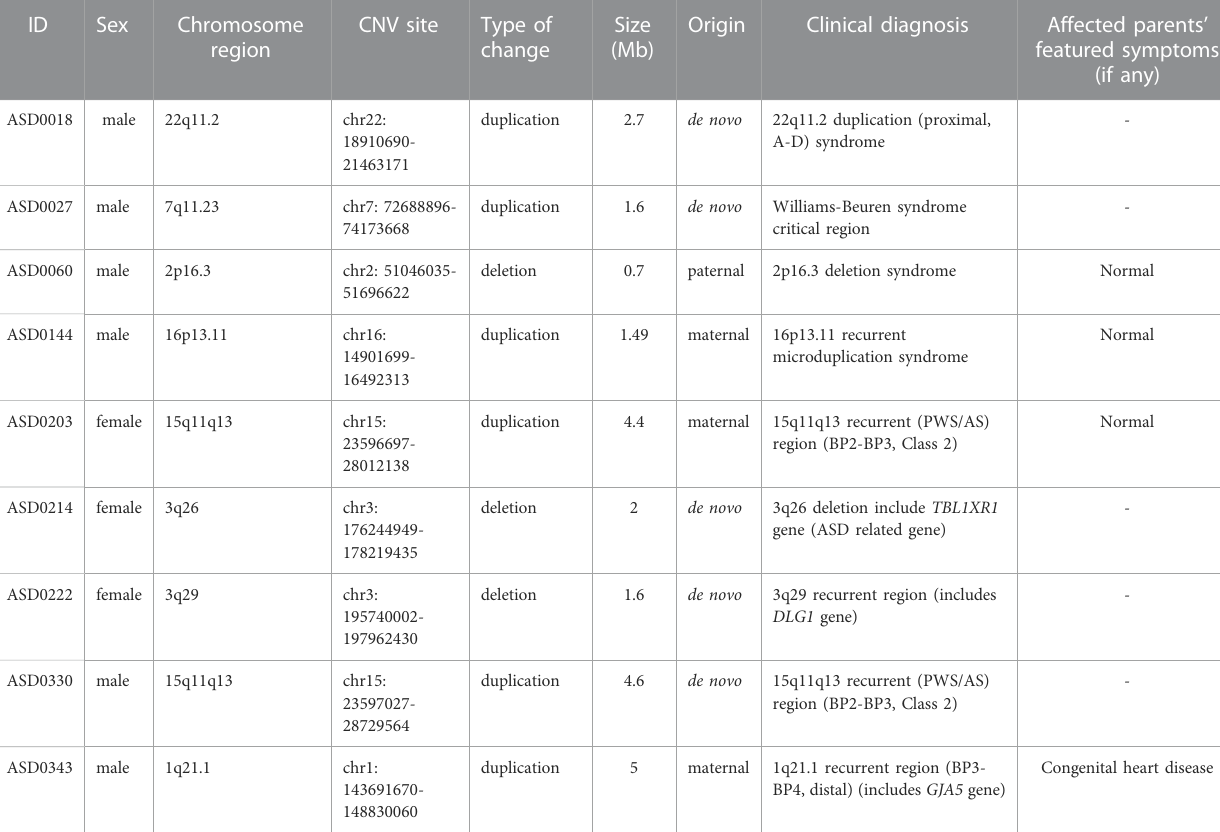
TABLE 2 CNV changes in 9 ASD